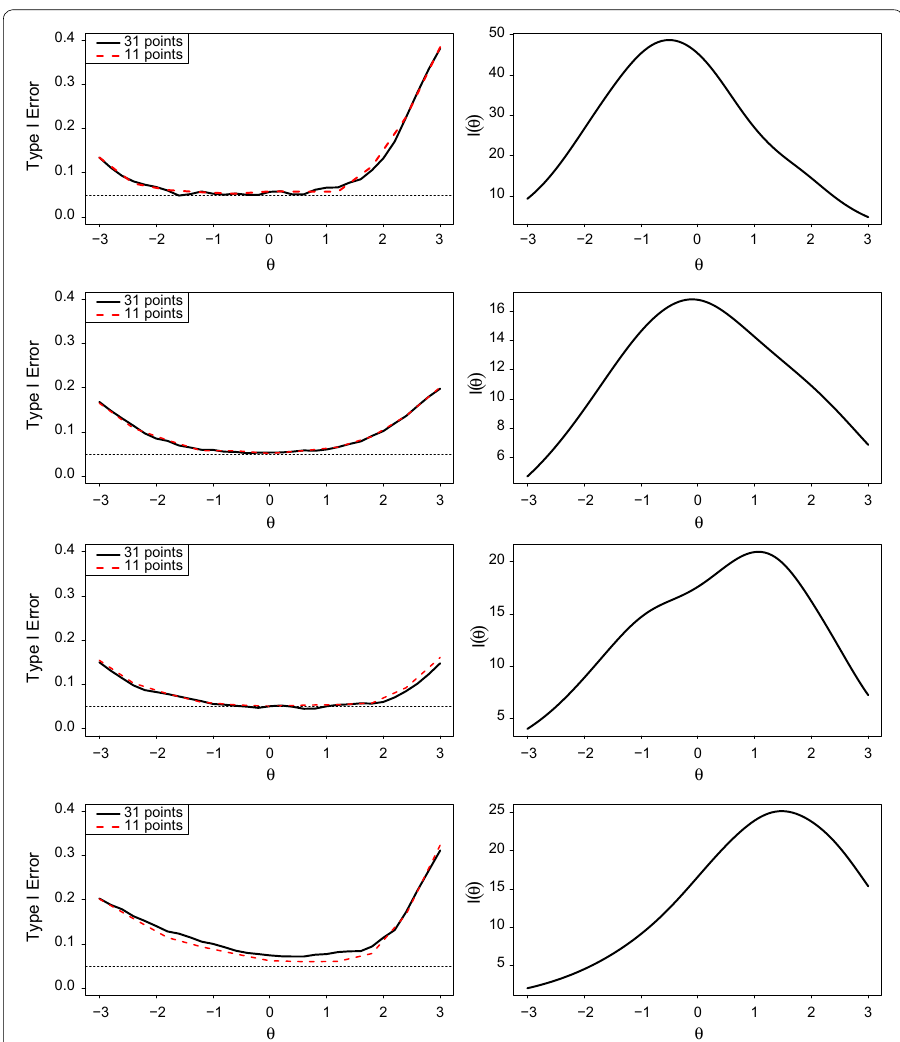
Fig. 2 Type I error rates for item-fit residuals ( left ) and test information functions ( right ) for the four NAEP data sets ( First row LTT math age 9; Second row reading grade 12; Third row math grade 8; Fourth row science grade